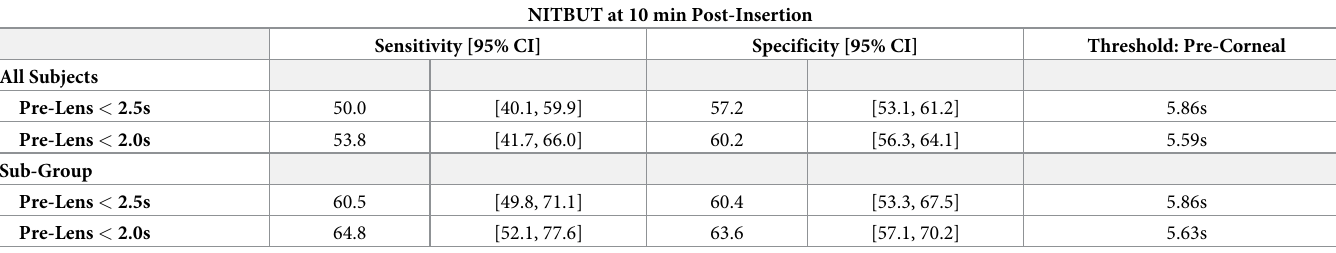
Table 2. Sensitivity and specificity of pre-corneal NITBUT (sec) for predicting subsequent pre-lens NITBUT at 10 min post-insertion below thresholds associated with any dryness symptoms (2.5 sec) and severe dryness symptoms (2.0